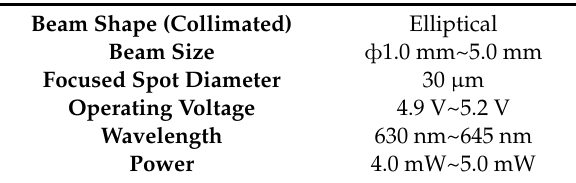
Table 1. Specifications of the laser